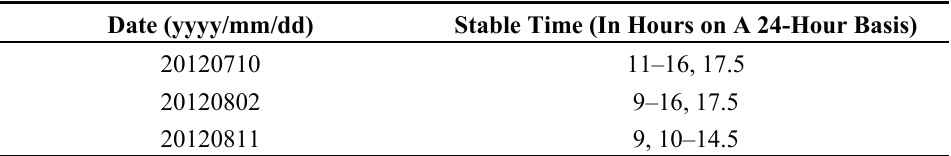
Table 3. Stability of EF EC on 10 July, 2 August, and 11 August of